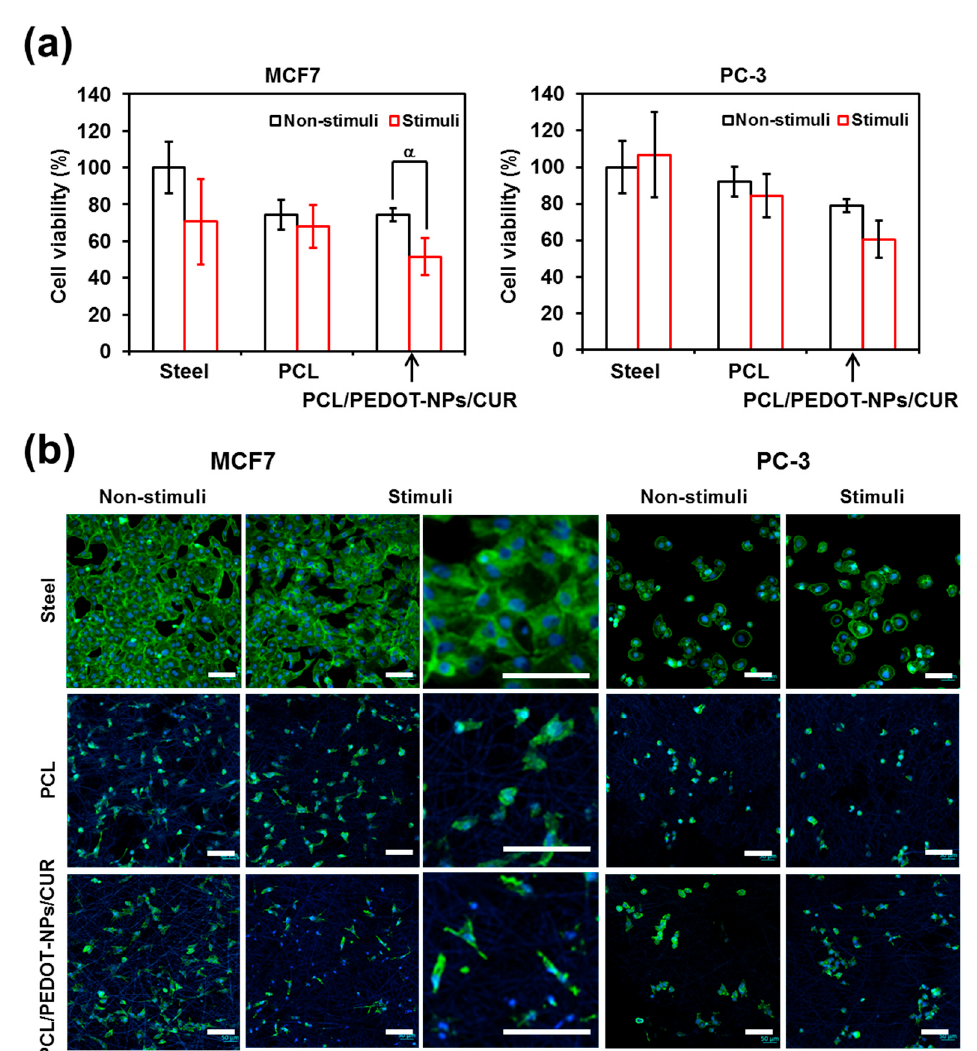
Figure 5. ( a ) Relative cell viability of PC-3 and MCF7 without and with electrical stimuli (1 pulse of 0.5 V for 1 min). ( b ) Morphology of cells cultured onto stainless steel pins and both PCL and PCL/PEDOT-NPs/CUR fibrous mats without and with electrical stimuli (1 pulse of 0.5 V for 1 min). Confocal microscopy micrographs recorded after 48 h of cell culture (non-stimuli) or 24 h after applying the electrical stimuli, which in turn, was carried out 24 h after starting the cell culture. Cells were stained for the nucleus in blue (Hoechst) and F-actin in green (Phalloidin Atto 488). Magnified images are also displayed for MCF7 cells cultured with electrical stimuli. In all cases, scale bar = 100 µm. Each data point in ( a ) corresponds to the average of three samples and the error bars refer to the respective standard deviation. The Greek letter in the column indicates a significant difference ( p < 0.05) when one-way ANOVA and Turkey’s multiple comparison tests have been applied.